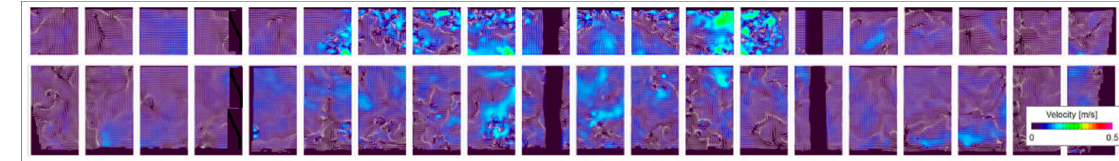
Figure 7. Flow measurement results obtained by scheme C.